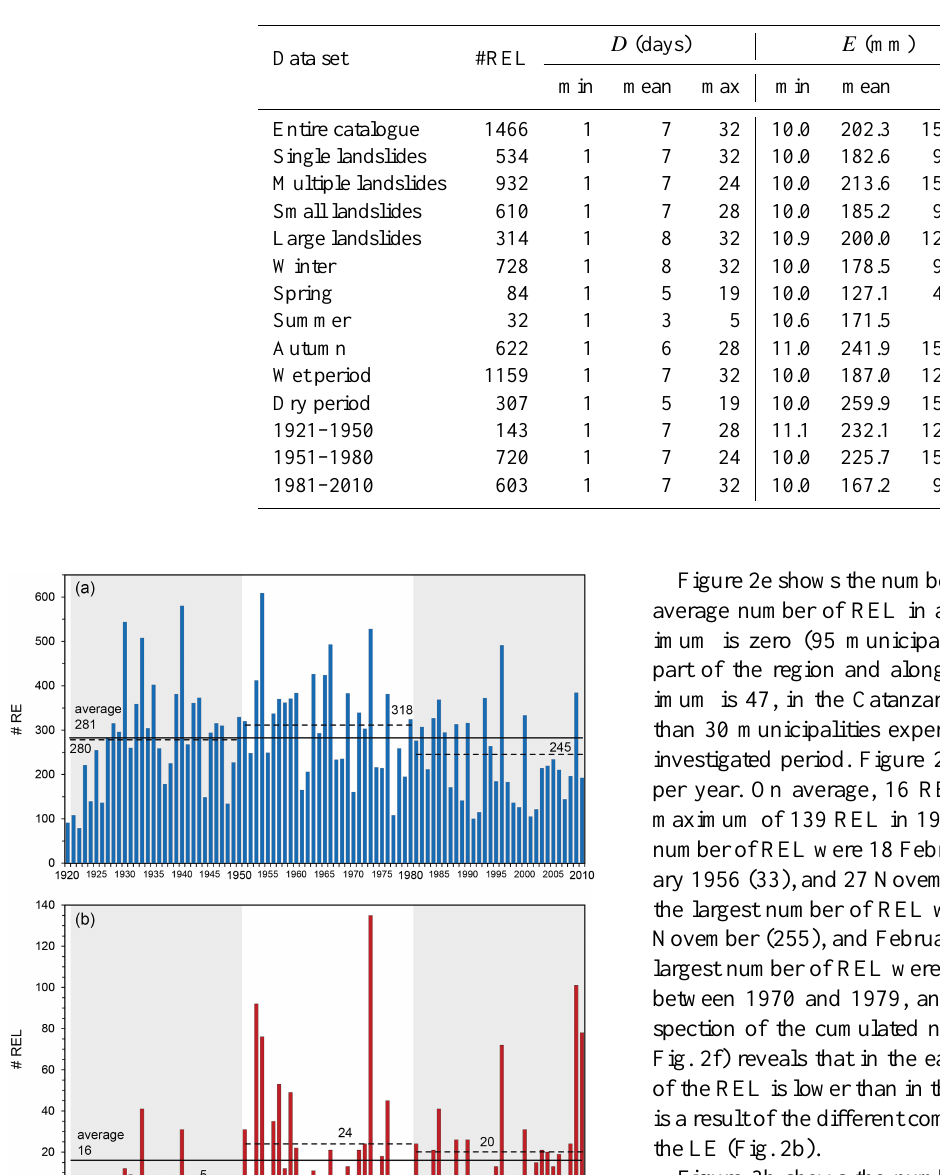
Table 1. Summary statistics for rainfall events with landslides (REL) in Calabria for the entire catalogue, and for different periods and landslide subsets. Legend: #REL, number of rainfall events with landslides; D , duration of a rainfall event (in days); E , cumulated event rainfall (in mm).